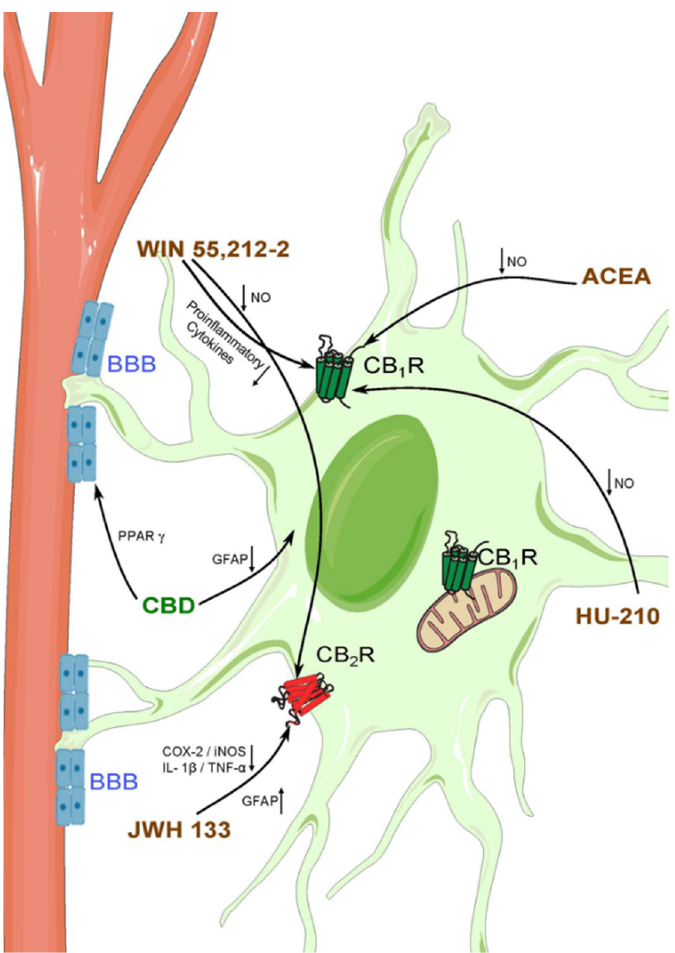
Figure 2. Schematic representation of the interactions of cannabinoid compounds with astrocytes in the context of epilepsy and neuroinflammation. Synthetic cannabinoids (brown) are able to interact with CB 1 and CB 2 receptors located in astrocytes. Moreover, some phytocannabinoids (green) modulate astrocyte functions on a cannabinoid-receptor-independent manner.